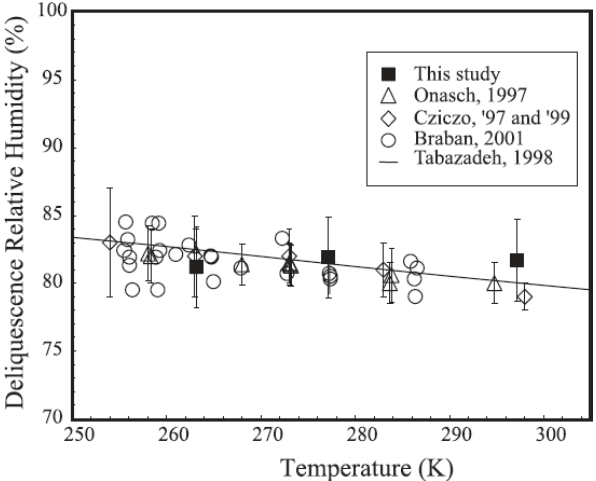
Figure 1. Comparison of DRH values as a function of tempera- ture (250–300K) measured by different studies, including Onasch, 1997 (Onasch et al., 1997), Cziczo, ’97 and ’99 (Cziczo et al., 1997; Cziczo and Abbatt, 1999), Braban, 2001 (Braban et al., 2001), and Tabazadeh, 1998 (Tabazadeh and Toon, 1998). Reprint with permis- sion by Brooks et al. (2002). Copyright 2002 John Wiley & Sons,